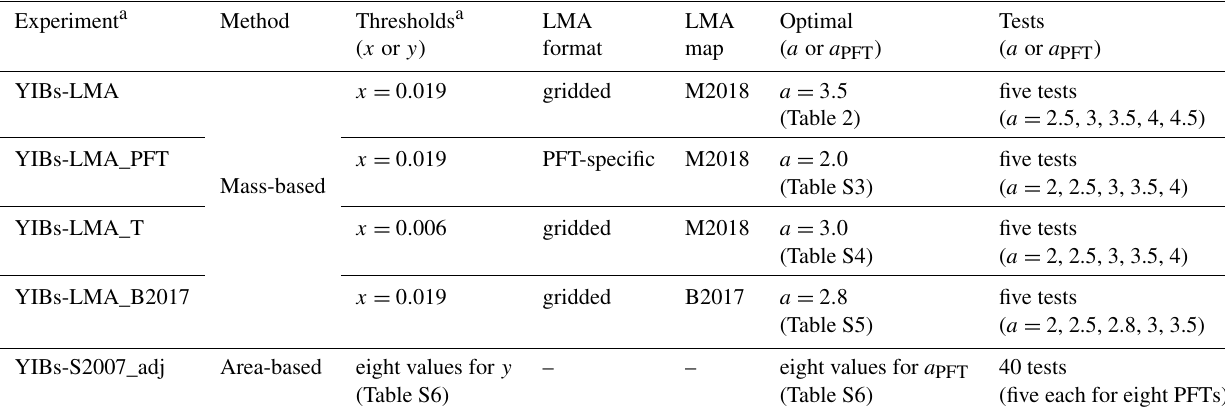
Table 1. Summary of simulations.